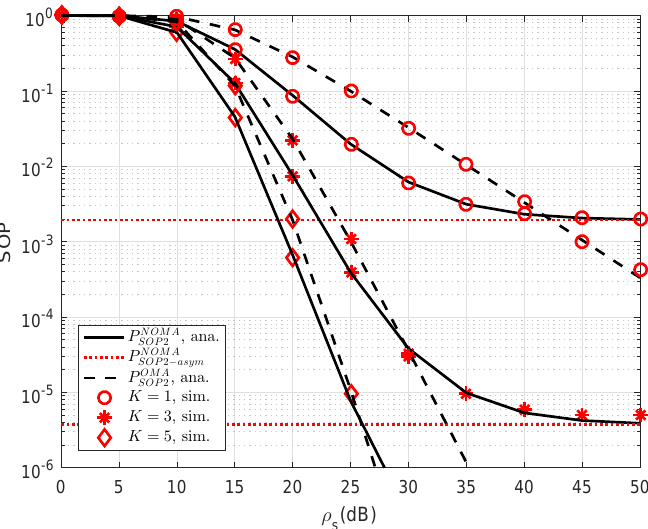
Figure 3. Comparison study on SOP of NOMA and OMA for User D2 versus ρ S = ρ R as changing K ( λ D 1 = λ D 12 = λ SRk = λ kD 2 = λ E = 1, ρ E = − 10 dB, R 2 =